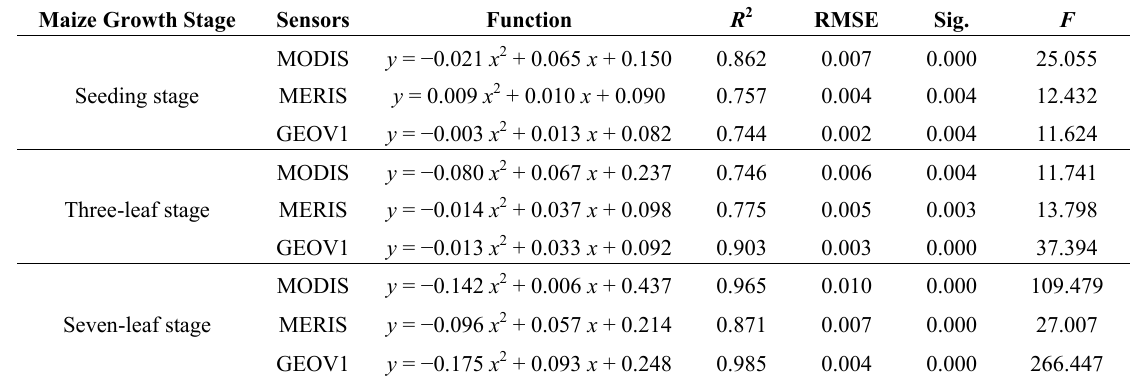
Table 4. The fitting relationships between residential area percentage and maize FPAR at different